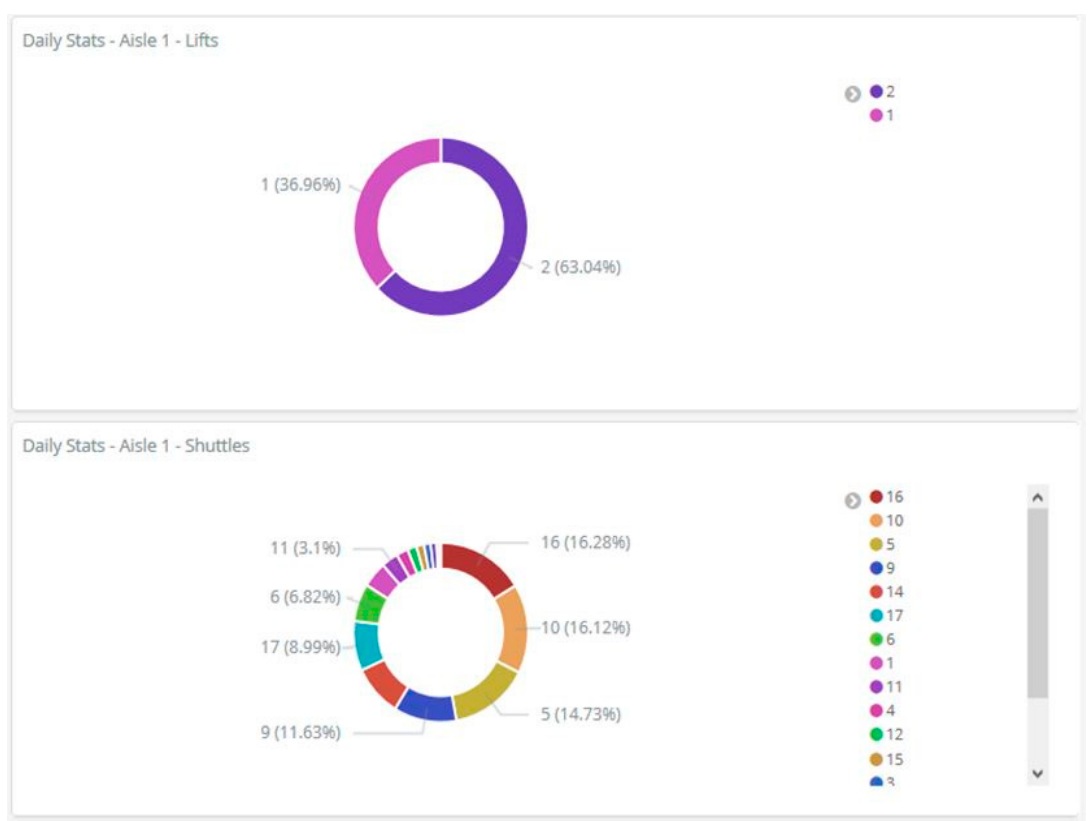
Figure 9. Box automation racking and shuttles. ( a ) an example of the racking system structure, ( b ) the shuttle used for moving the containers within the same level.